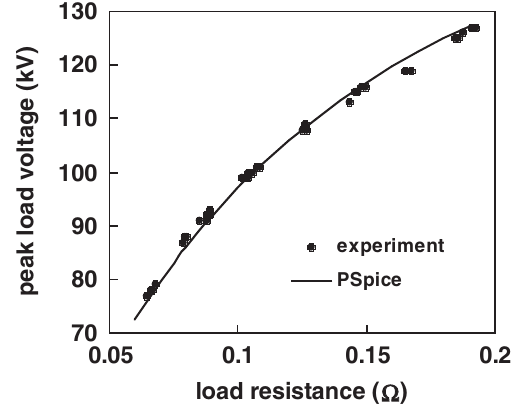
FIG. 6. Energy delivered to the load during the main pulse as a function of the load resistance. The experimental results (dots) are compared with the PSPICE simulation (solid